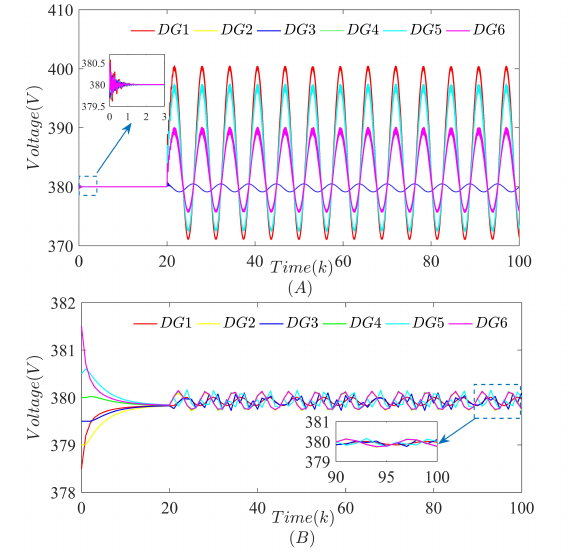
Figure 12. Consensus performance of the DGs using different resilient strategies under a time- dependent attack: ( A ) the strategy in [17]; ( B ) the proposed